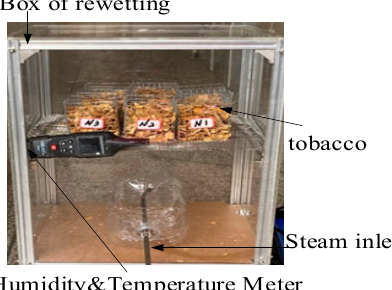
Figure 4. The experimental rewetting box.